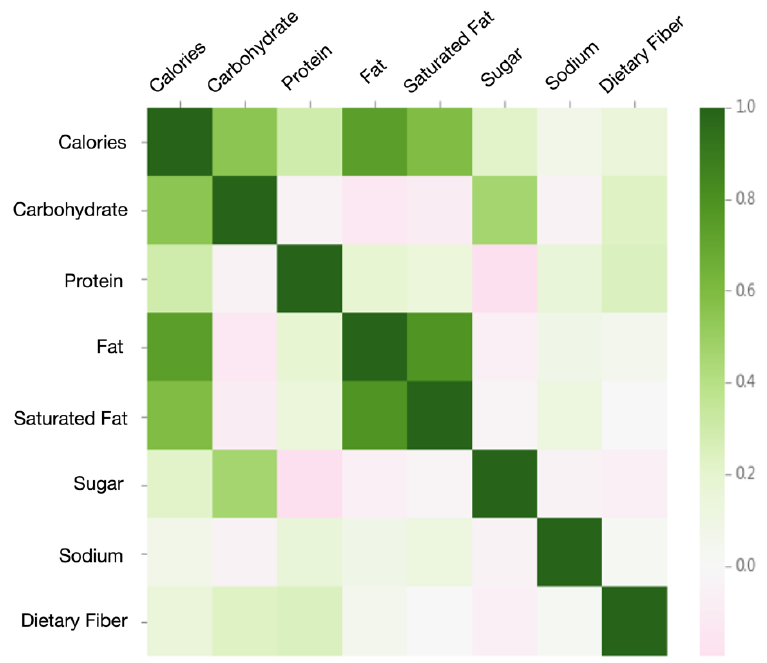
Figure 11. Pearson correlation matrix between nutrients in recipes.